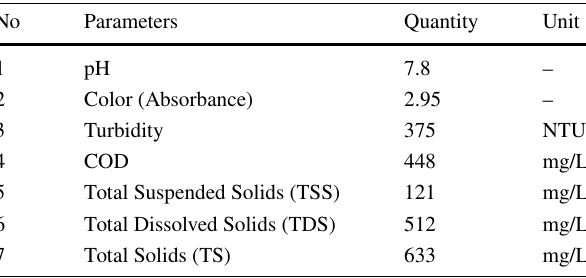
Table. 2 Characteristics of wastewater